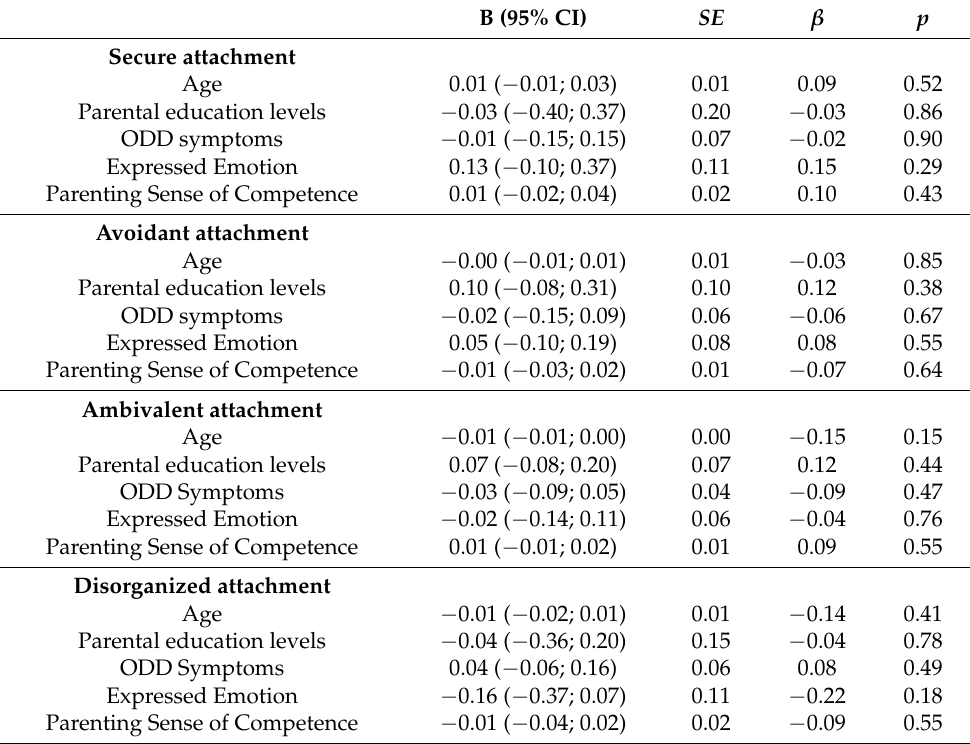
Table 3. Bootstrapped linear regression analyses within ADHD